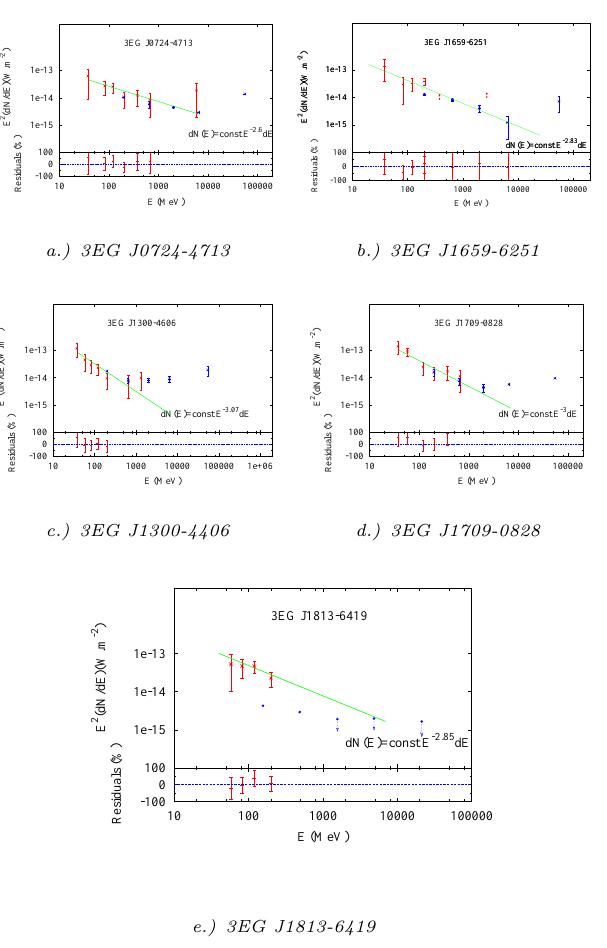
Figure 3: The gamma-ray spectra of the EGRET (30 MeV - 10 GeV) and coinciding Fermi-LAT (20 MeV - 300 GeV)